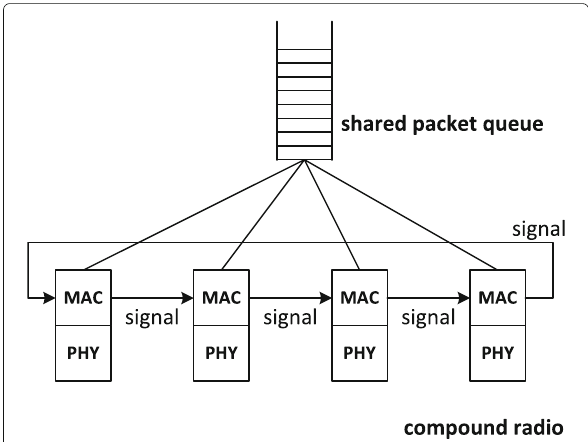
Fig. 8 Structure of compound radio used to implement the proposed scheme. A MAC-PHY pair operates for each narrow channel. Each MAC runs 802.11 DCF, but does not have its own packet queue. Instead, when the channel access is granted, the MAC dequeues a packet from the shared packet queue and transmits the packet. Neighboring MACs are connected so that when a node successfully receives an ACK, the MAC of channel i can signal the MAC of channel i + 1 to perform privileged access